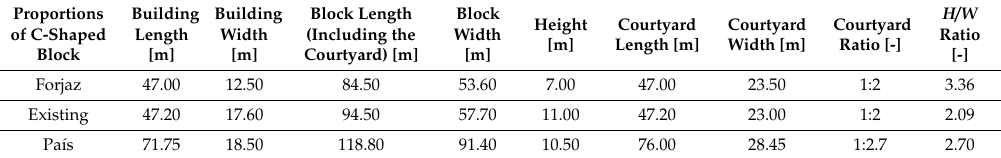
Table 1. Proportions of Forjaz’s ‘C-shaped’ block, of the existing ‘C-shaped’ block, and of the proposed Pa í s’ ‘C-shaped’ block.